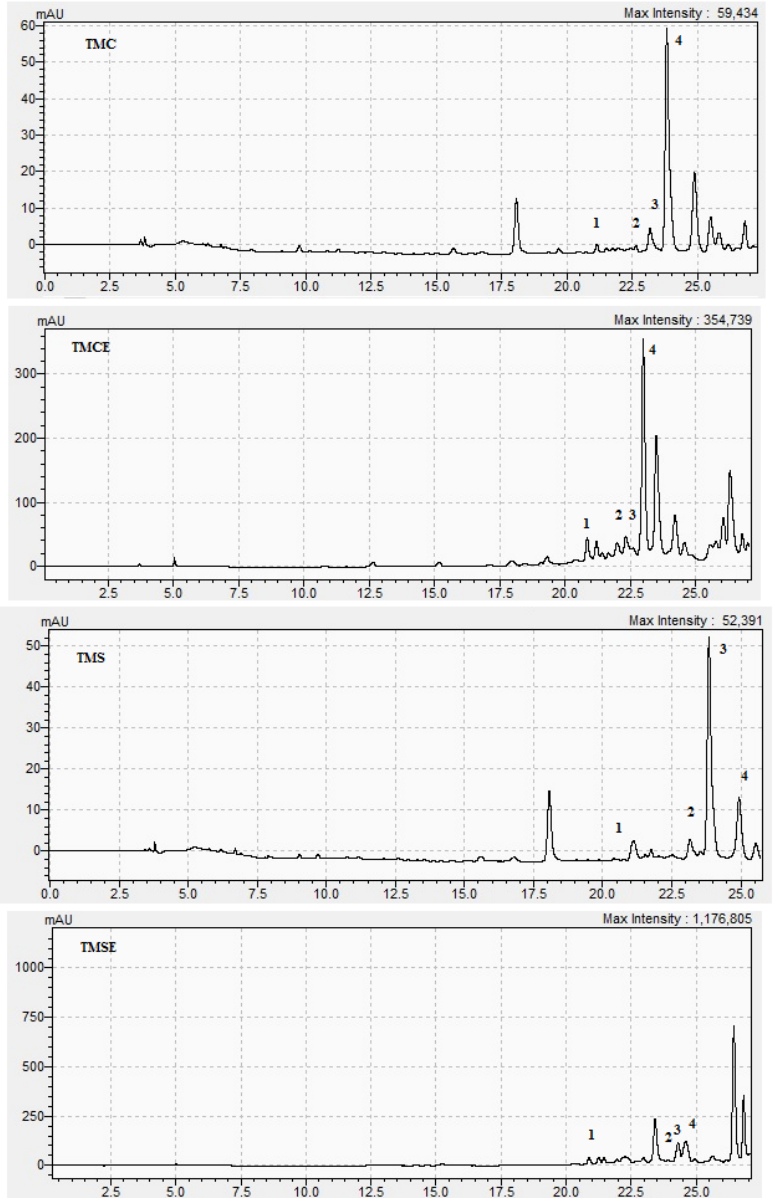
Figure 1. HPLC-DAD chromatograms at 254 nm for 1 = luteolin, 2 = kaempferol, 3 = apigenin, and 4 = rosmarinic acid .